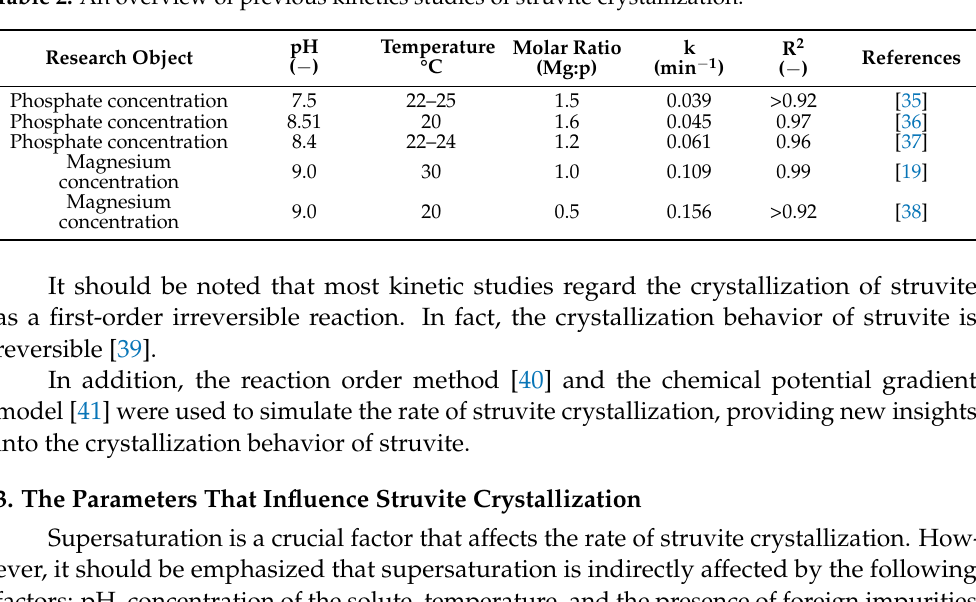
Table 2. An overview of previous kinetics studies of struvite